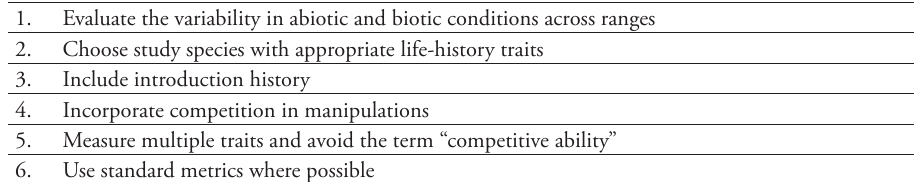
table 4. A framework for testing post-establishment evolution